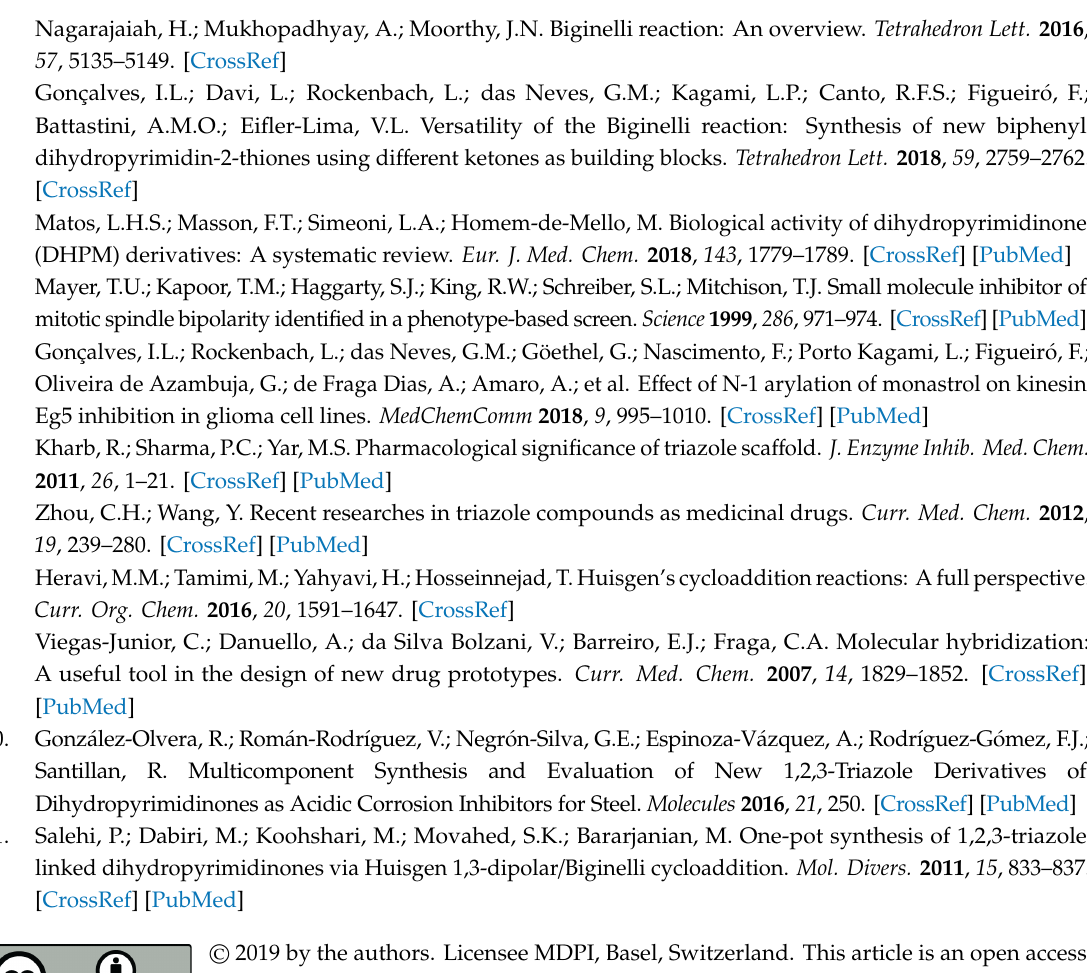
Supplementary Materials: The following are available online, Figure S1: 1 H NMR spectrum (400 MHz, CDCl 3 ) of compound ( 5 ), Figure S2: 13 C NMR (100 MHz, CDCl 3 ) and APT spectrum of compound ( 5 ), Figure S3: 1 H NMR spectrum (400 MHz, DMSO- d 6 ) of compound ( 8 ), Figure S4: 13 C NMR (100 MHz, CDCl 3 ) and APT spectrum of compound ( 8 ), Figure S5: HSQC experiment for compound ( 8 ), Figure S6: HRMS spectra of compound ( 8 ), Figure S7: FT-IR spectrum of compound ( 8 ), Figure S8: UV-visible spectrum of compound ( 8 ) in ethyl